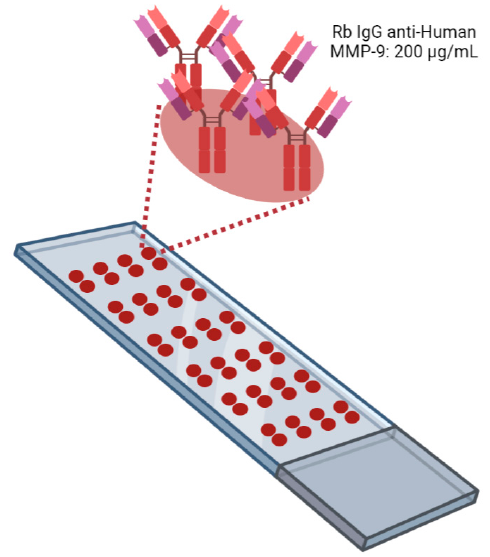
Figure 7. Schematic representation of a microscope glass slide with AbMAs printed. Twenty-four AbMAs with two spots of rabbit IgG anti-human MMP-9 at 200 µ g/mL in SIVG 0.05% were immobilized onto treated slides. Image created with